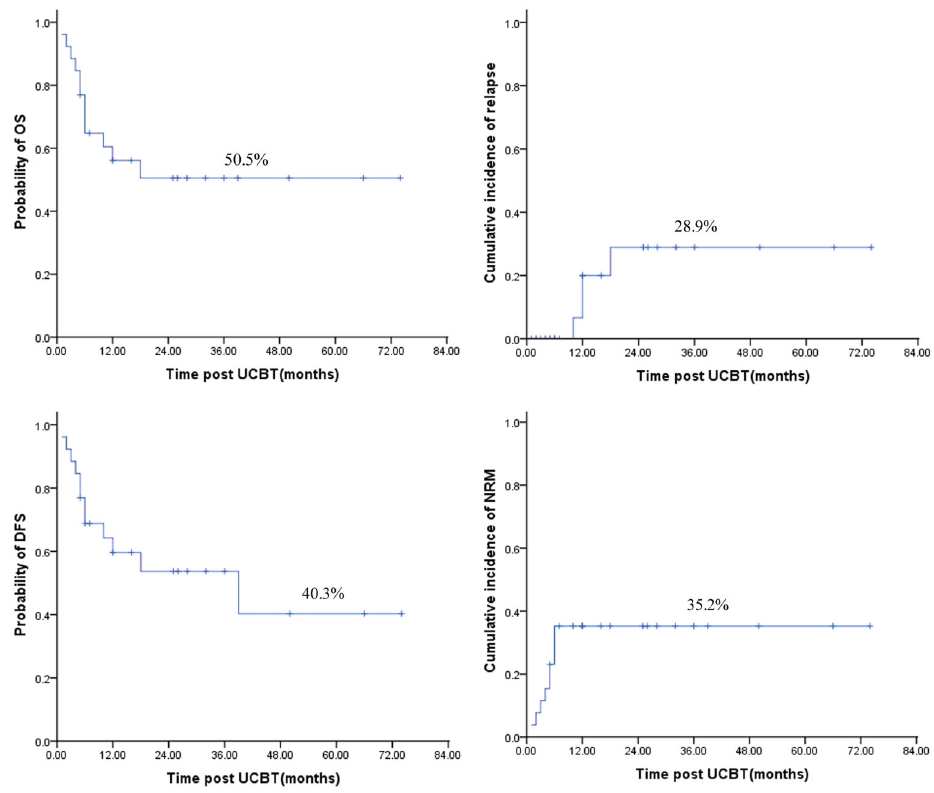
Figure 1. Overall survival (OS), disease-free survival (DFS), relapse and non-relapse mortality (NRM) in patients undergoing cord blood transplantation. UCBT: umbilical cord blood